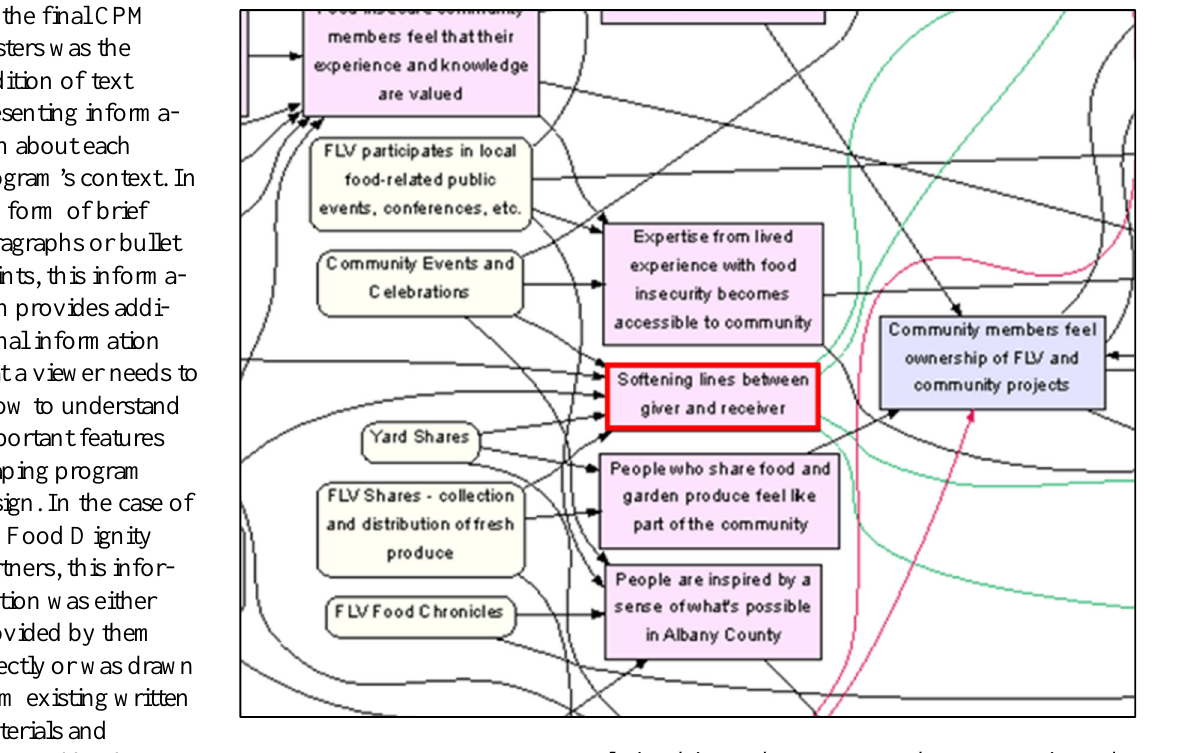
Figure 3. Excerpt Showing a Key Short-Term Outcome in the Feeding Laramie Valley